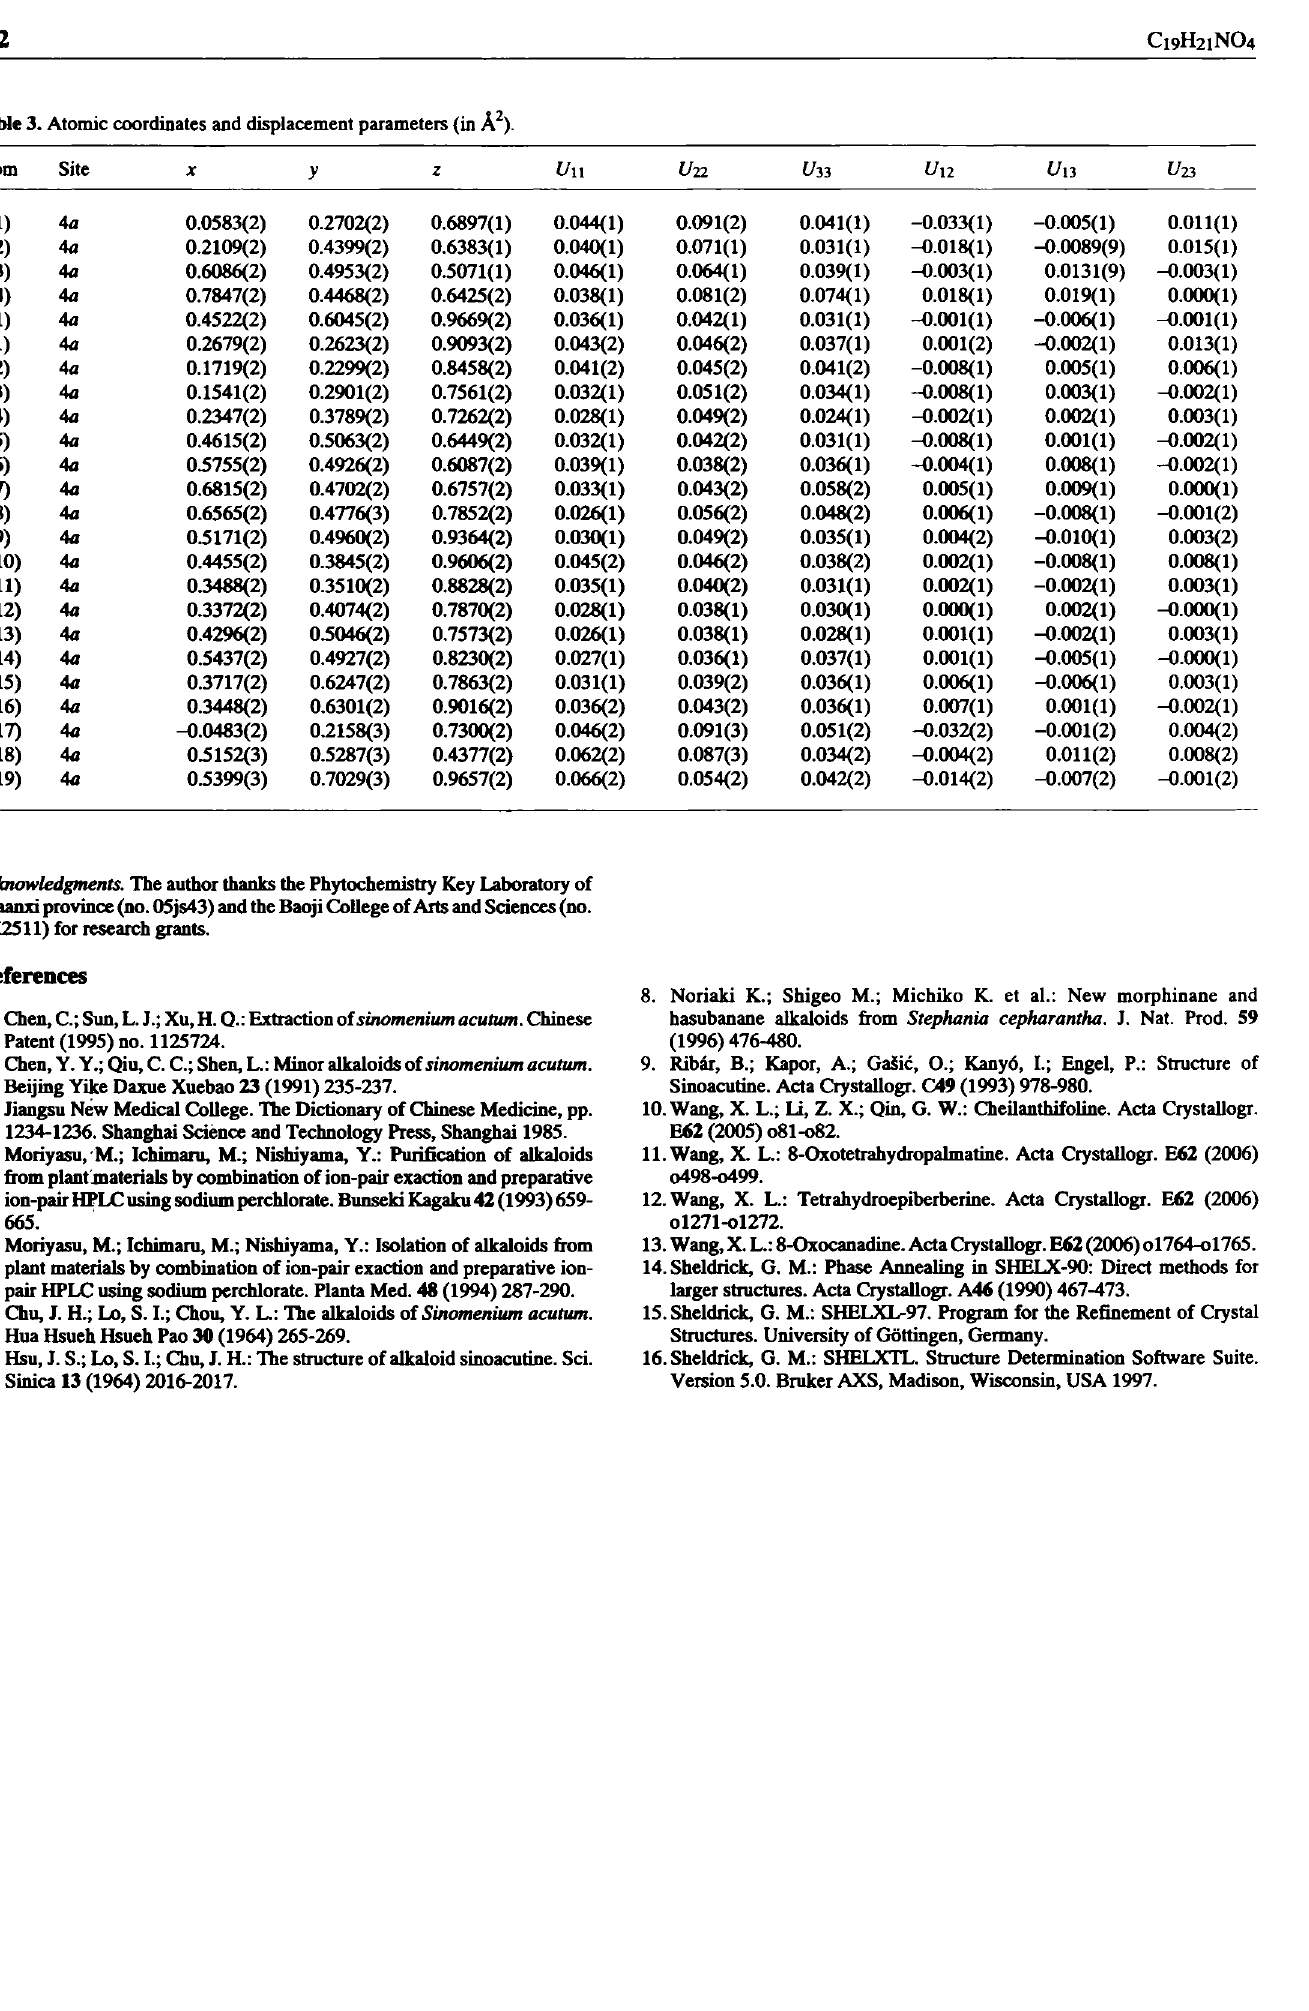
Table 3. Atomic coordinates and displacement parameters (in Ä 2